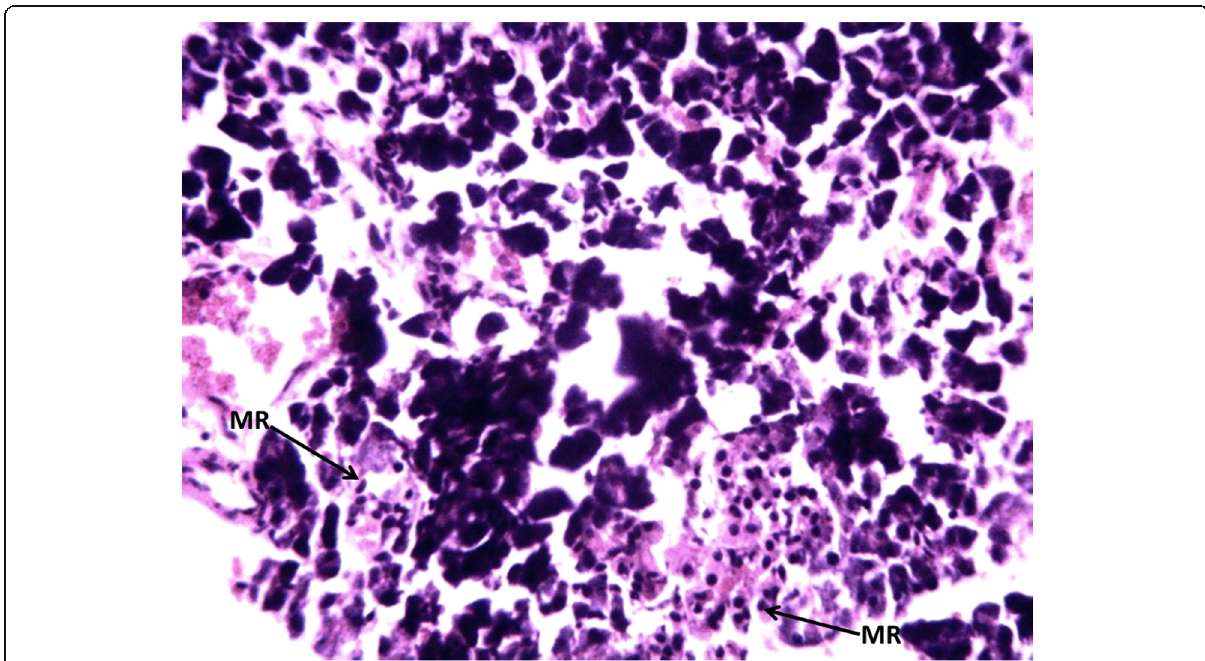
Fig. 3 Histology of the pancreas section stained with hematoxylin and eosin in the group treated with 2000 mg/kg of aqueous stem bark extract of P. macrophylla , × 250. MR, moderately restored pancreatic islet